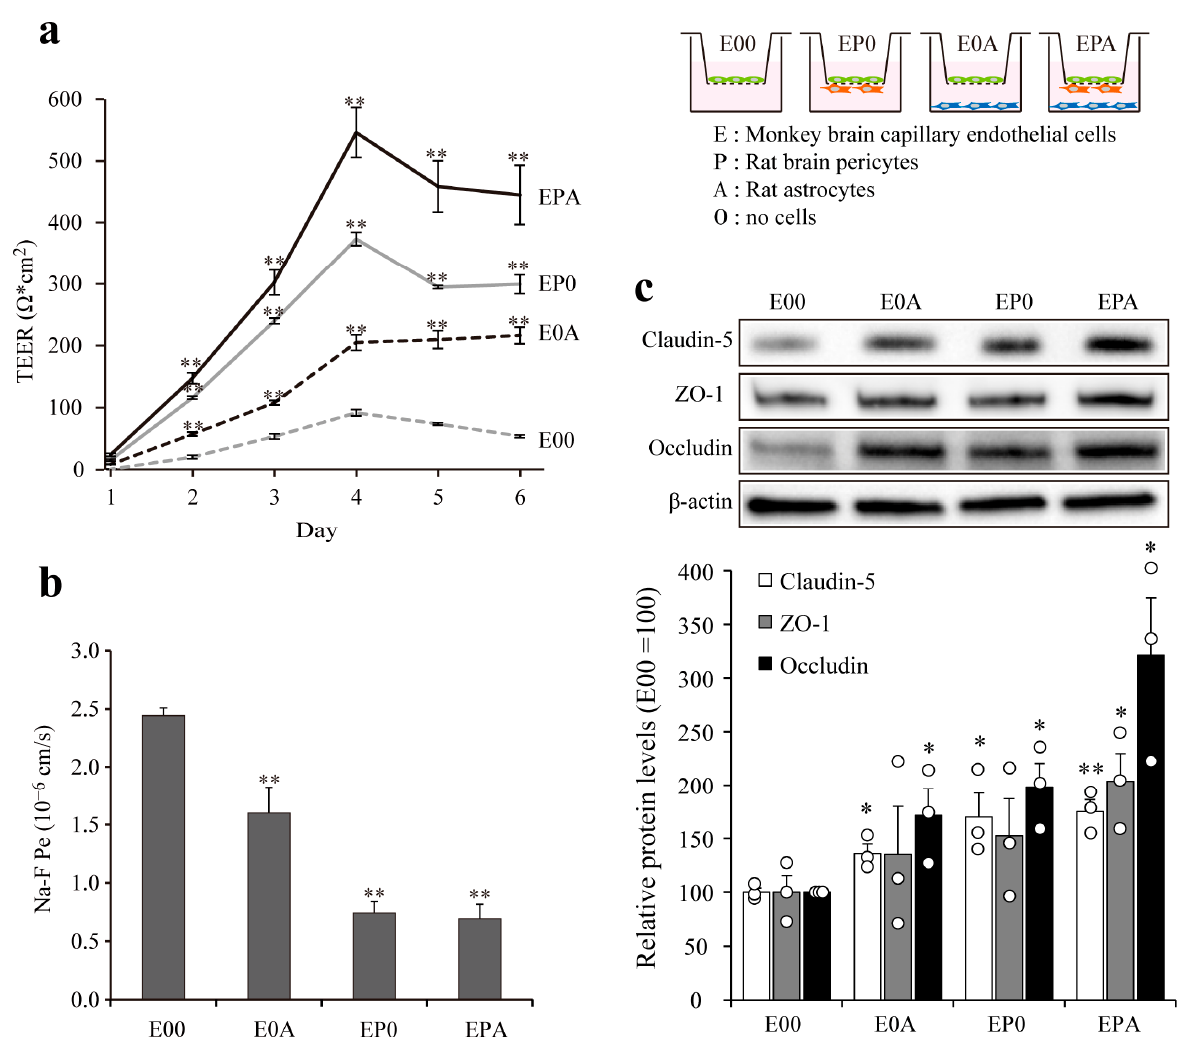
Figure 4. Comparison of the barrier properties of BBB mono- and co-culture models. Barrier function of different BBB models prepared from brain endothelial cells (E), astrocytes (A), and pericytes (P) were measured by ( a ) transendothelial electrical resistance (TEER, expressed as Ω × cm 2 ) and ( b ) endothelial permeability coefficient for sodium fluorescein (Na–F P e , expressed in 10 − 6 cm/s). Data are presented as means ± SEM (n = 3, ** p < 0.01 vs. E00). ( c ) Expression of the tight junction proteins ZO-1, occludin, and claudin-5 in different BBB models detected by western blot. The relative level of the proteins was determined by densitometry. Data are presented as means ± SEM (n = 3, * p < 0.05, ** p < 0.01 vs. E00).